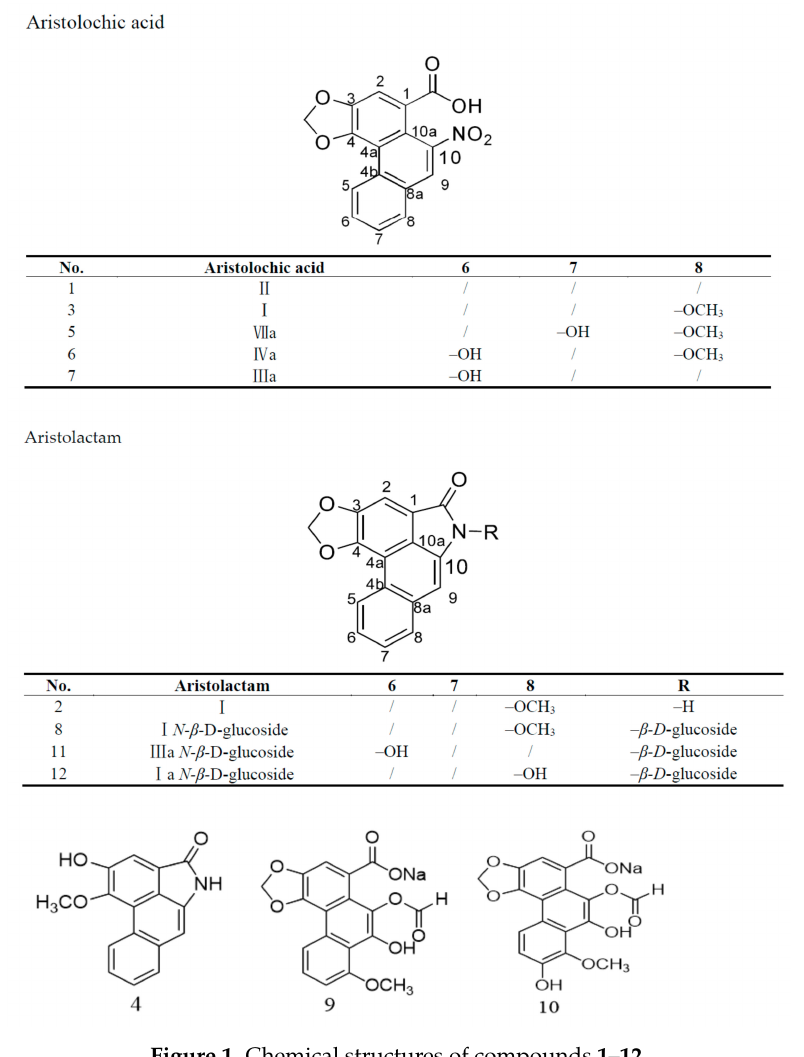
Figure 1. Chemical structures of compounds 1 – 12